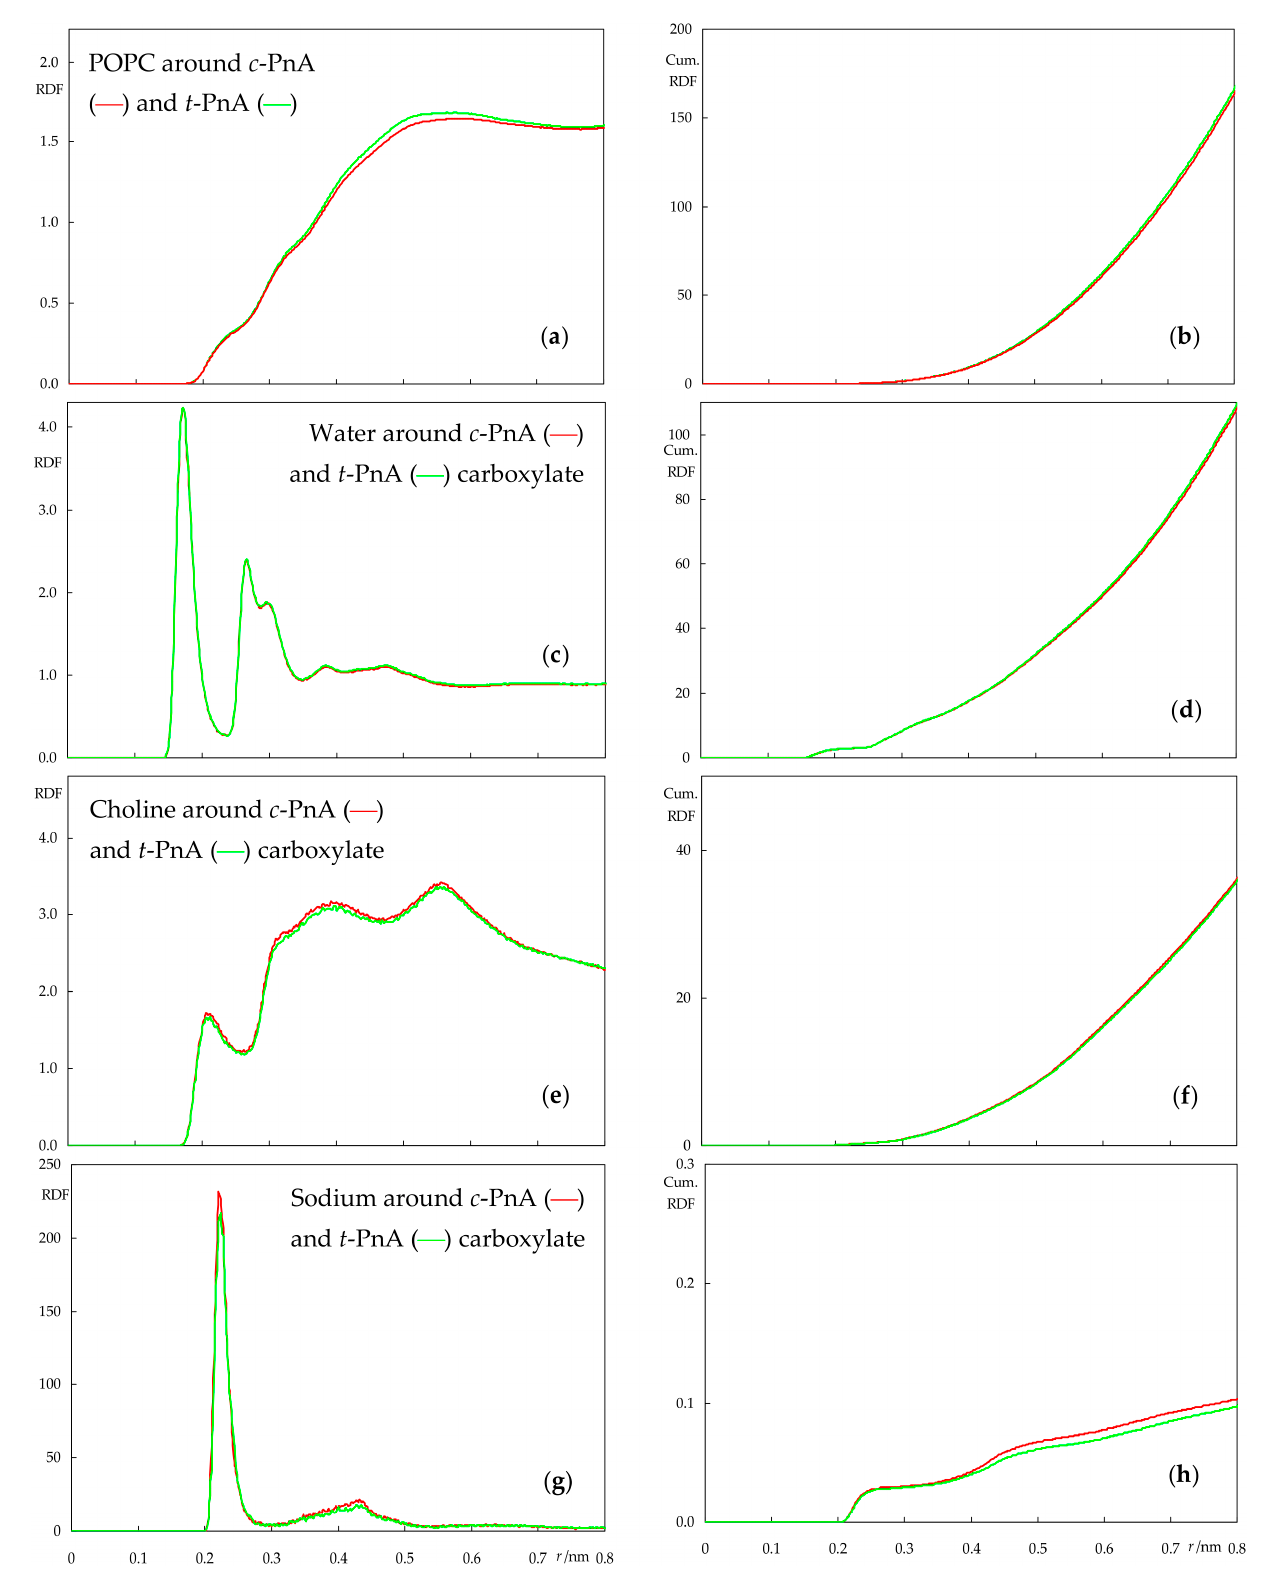
Figure 8. Atom–atom radial distribution density functions (RDFs, left plots) and their cumulative counterparts (cumulative RDFs, right plots) of lipid around PnA ( a , b ) and water ( c , d ), lipid choline ( e , f ) and sodium ion ( g , h ) around PnA carboxylate, calculated for the POPC simulations. Red and green curves refer to simulations with c ‐ PnA and t ‐ PnA, respectively.